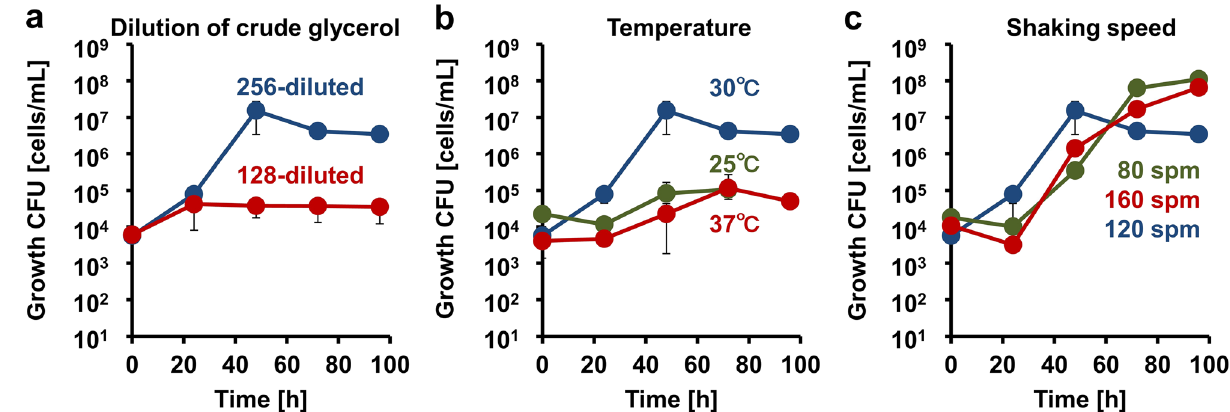
Figure 2. Assessment of culture conditions. ( a ) Effect of crude glycerol concentration on growth. Blue and red- colored circles represent 1/256 and 1/128-fold dilution, respectively. ( b ) Effect of temperature on growth. Blue, green, and red-colored circles represent 30, 25, and 37 °C, respectively. ( c ) Effect of shaking speed on growth. Blue, green, and red-colored circles represent 120, 80, and 160 spm,